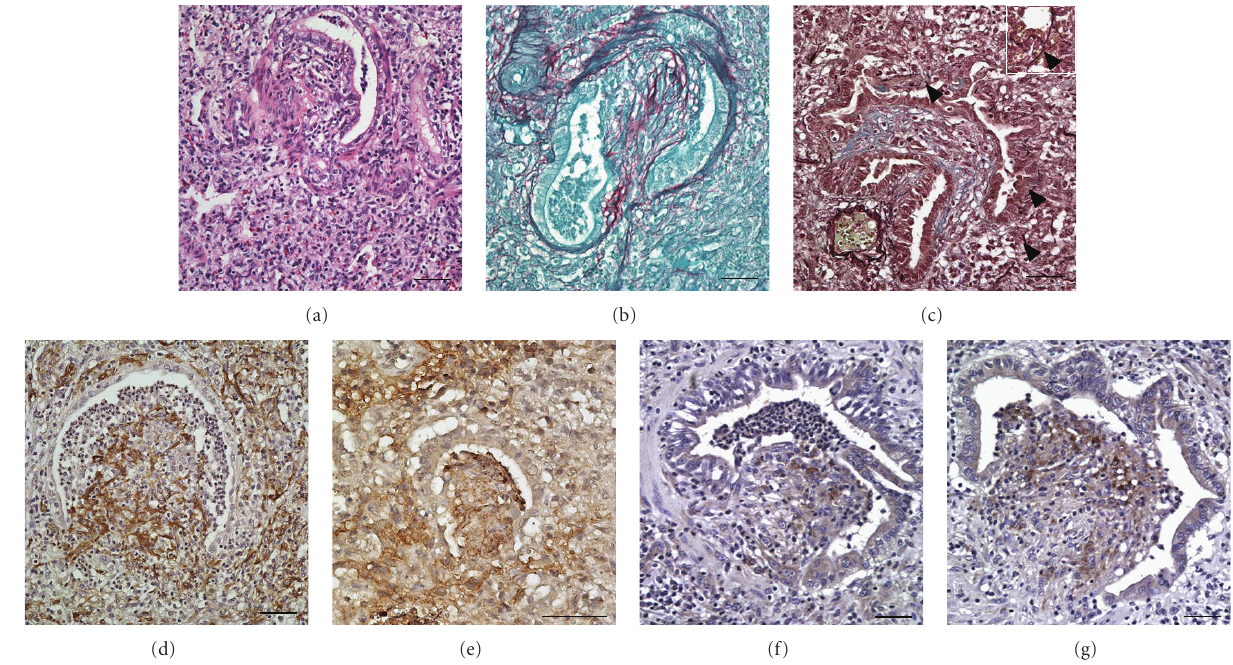
Figure 3: Histopathological constituents of BOOP lesion in specific staining. The representative picture showed the intraluminal plugs of loose connective tissue that occlude bronchioles in H&E stain (a). A large mount accumulation of collagen matrix was sawn cherry in picrosirius red stain (b) and strongly blue in OPIC stain (c) at the evaginated BOOP lesion. The elastic fibril revealed disruption and fragmentation in peribronchial alveolar septa ((c), arrow head) as compared to normal lung ((c) upright panel, arrow head). The proliferative cells of the intraluminal plugs and alveolar septa were identified as α -SMA positive MFBs (d) and OPN positive cells (e). MMP-2 (f) and MMP-9 (g) seemed to be expressed actively at the margin of intraluminal plugs of bronchioles as macrophage and myofibroblasts. The results shown represent one of six replicates in each independent experiment demonstrating similar results ( P < . 01 versus normal group). (Bar = 50 μ